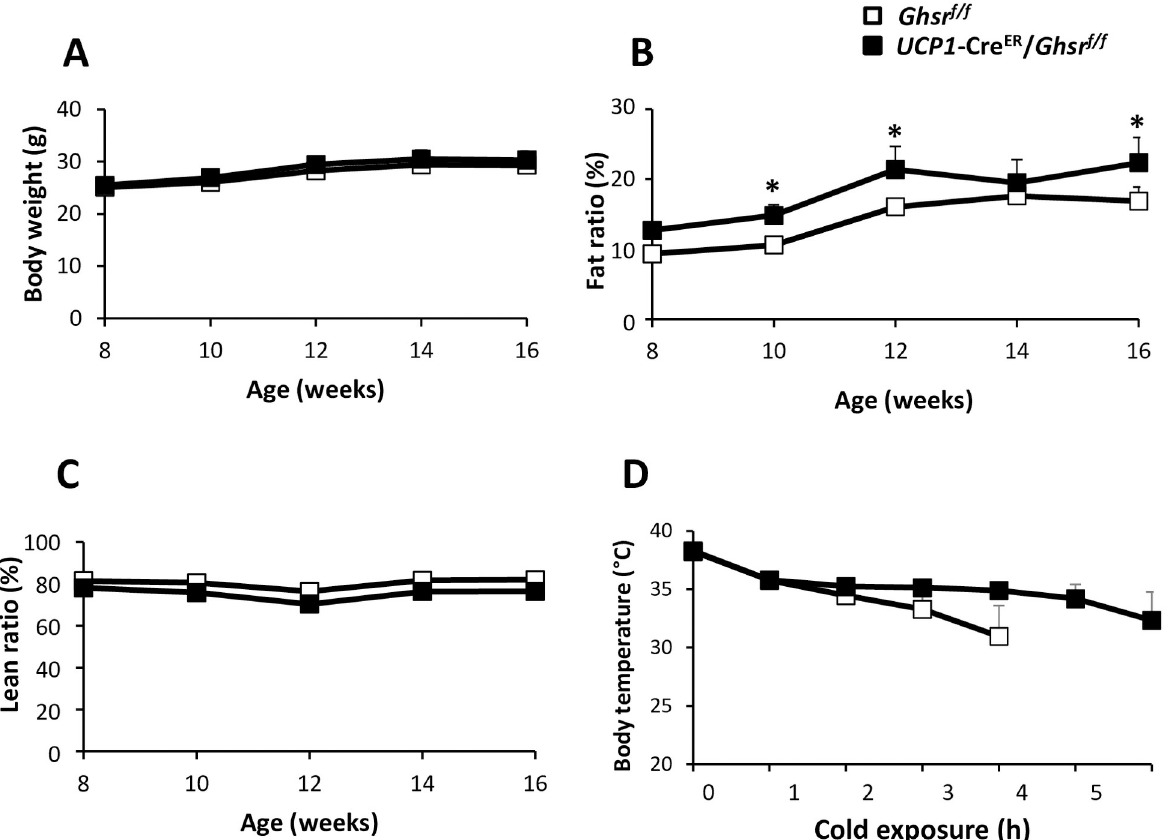
Fig 2. Body weight and body composition of RD-fed mice. ( A ) Body weight changes, ( B ) fat percentage, ( C ) lean percentage of Ghsr f/f mice and UCP1 -Cre ER / Ghsr f/f mice. ( D ) Rectal temperatures of Ghsr f/f and UCP1 -Cre ER / Ghsr f/f mice. 20-week-old mice were individually caged in a 4˚C cold room for 6 h, with free access to food and water. The rectal temperatures were collected every hour. All data were expressed as the mean ± SEM. n = 3–6, � P < 0.05, Ghsr f/f vs . UCP1 -Cre ER / Ghsr f/f